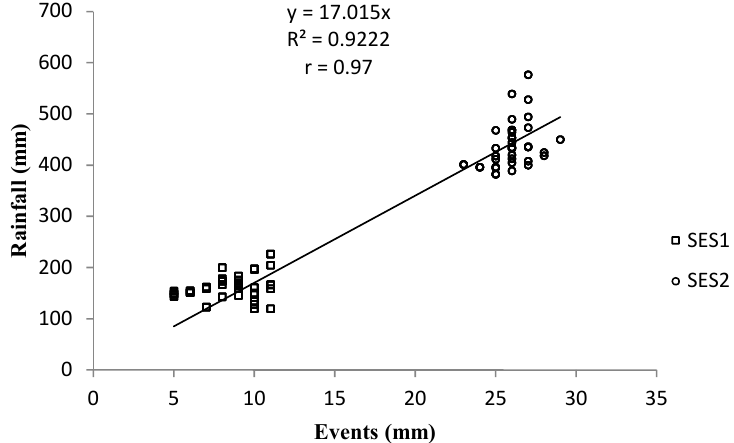
Figure 7. Total rainfall (mm) for two seasons related to the number of events.